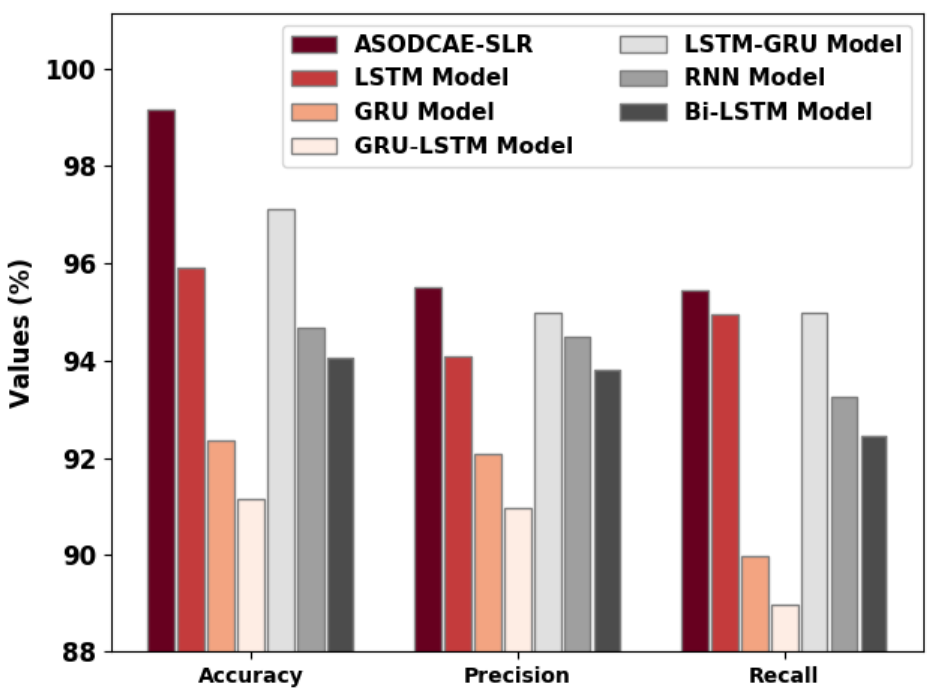
Figure 10. Comparative analysis of ASODCAE-SLR approach with existing algorithms.